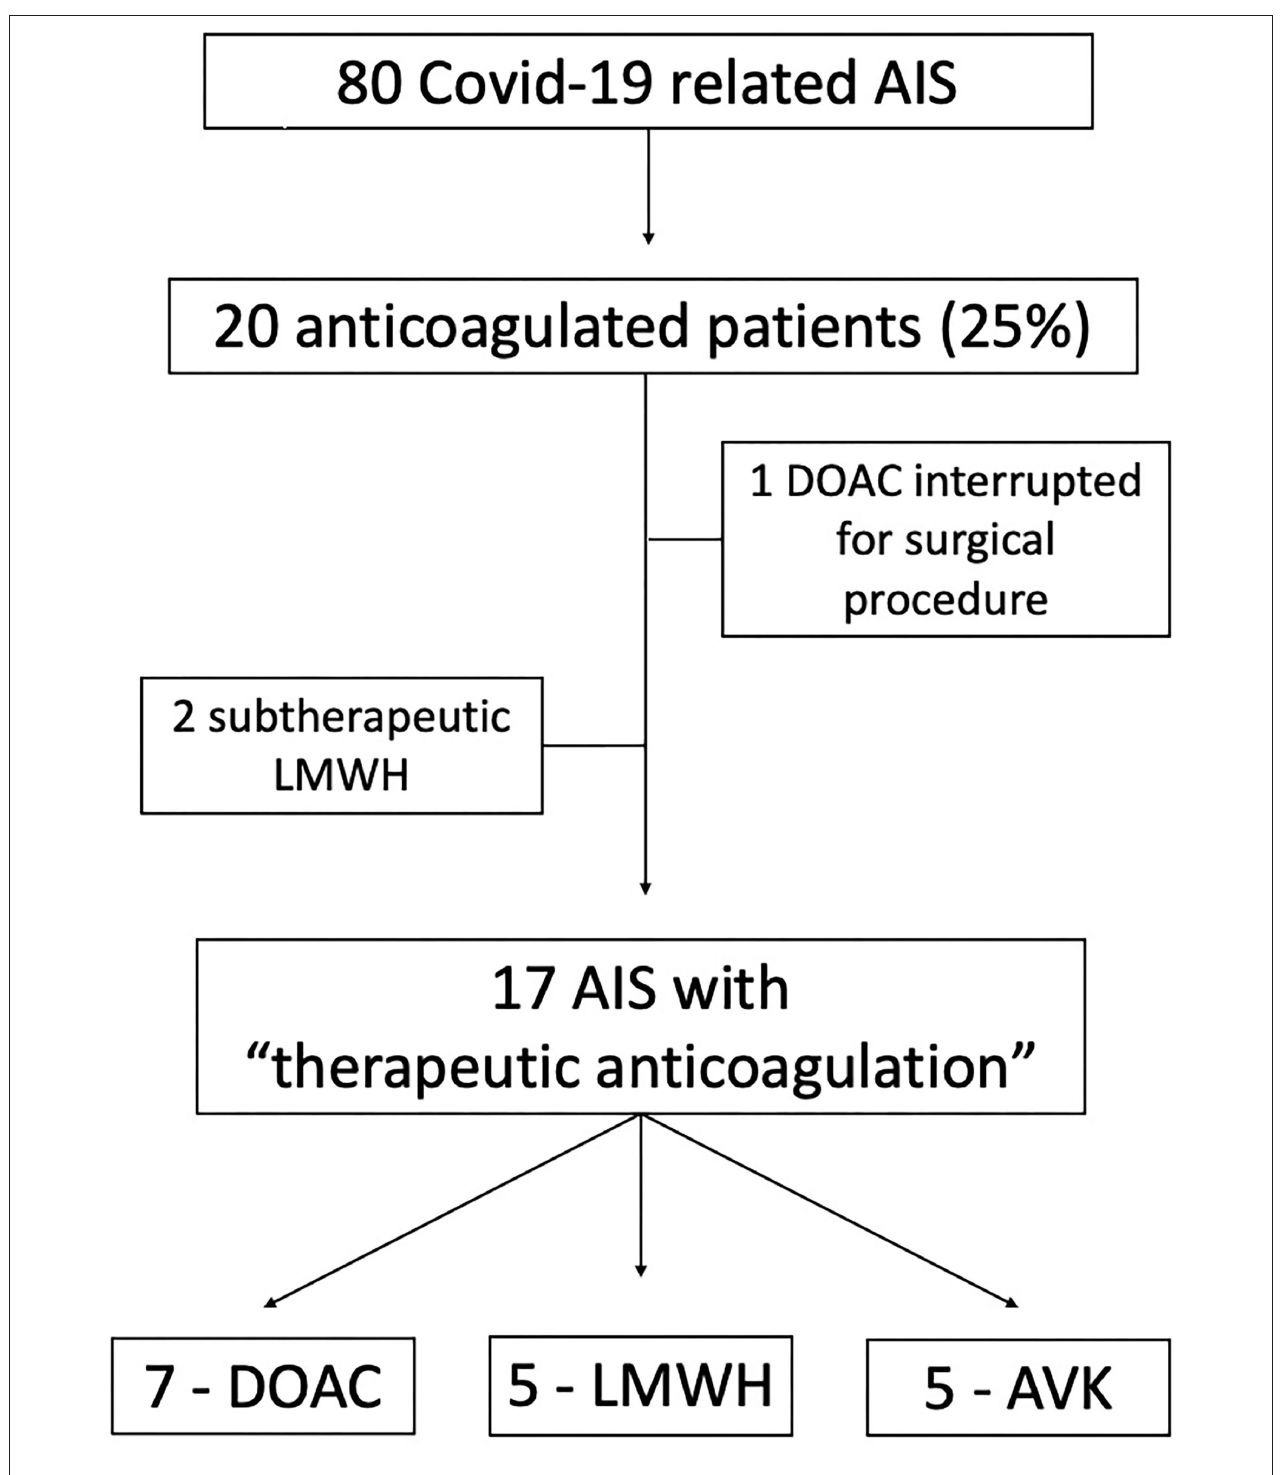
FIGURE 1 | Flowchart diagram of the patients’ selection process. AIS, Acute Ischemic Stroke; DOAC, Direct Oral Anticoagulant; LWMH, Low Molecular Weight Heparin; AVK, Anti K Vitamin anticoagulant.